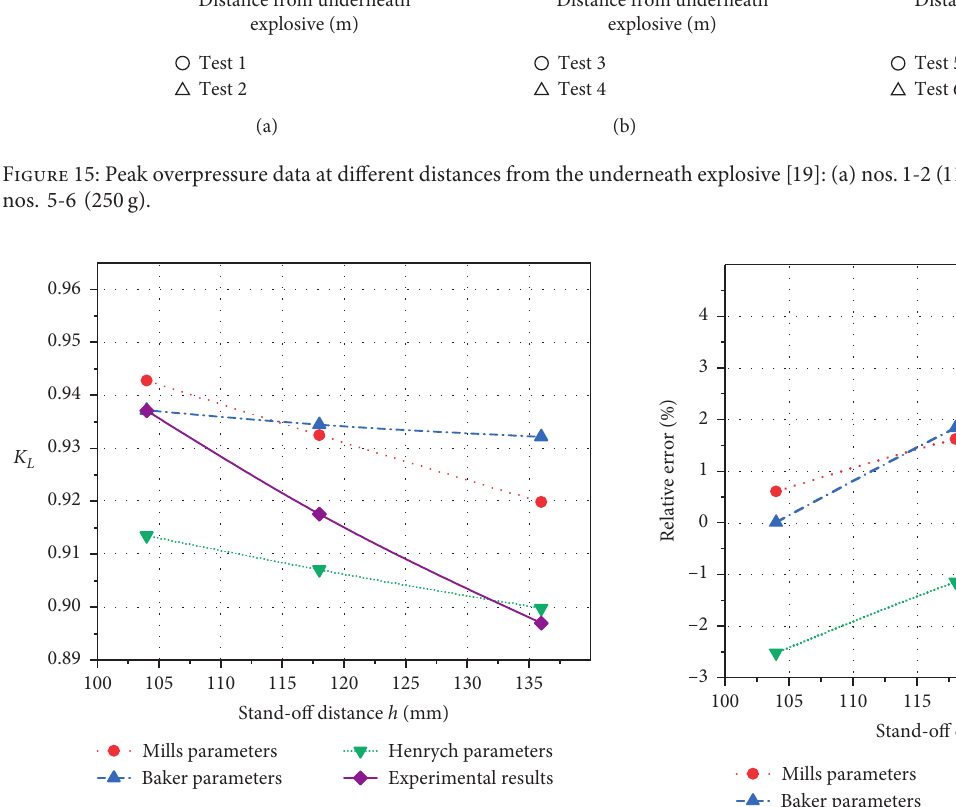
Figure 16: Comparison of K L between the theoretical results and the experimental results.